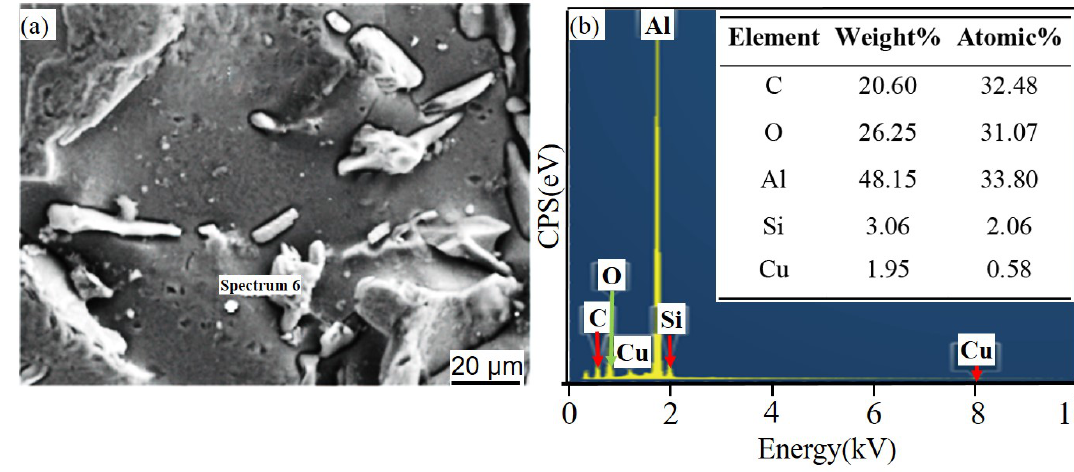
Figure 18. EDS of the interface of SiC 3D /6061Al after SL for 150 days. ( a ) SEM image of interface; ( b ) EDS of interface.